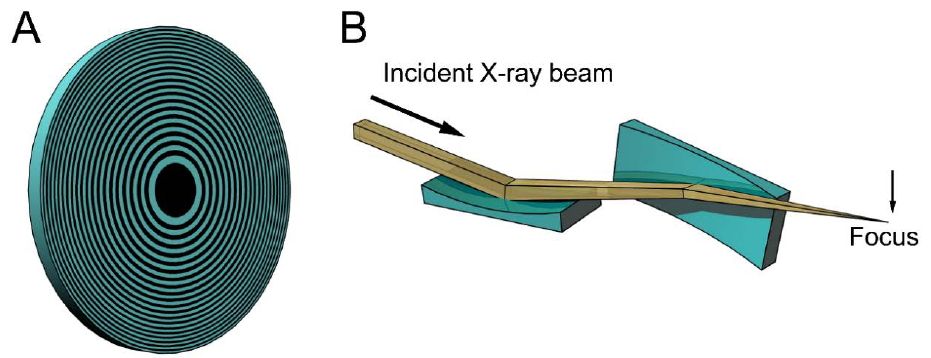
Figure 1. Schematic drawings of some focusing devices for X-ray beams. ( A ) Fresnel zone plate. This is a circular grating with alternating densities. The focal distance depends on the X-ray wavelengths and white X-rays do not focus; ( B ) Kirkpatric-Baez (KB) mirrors. These are most commonly used for focusing X-ray beams in synchrotron radiation facilities, but are rarely used as imaging optics. The focal distance does not depend on the X-ray wavelengths and can be changed by altering the bend of the mirrors. The drawings are exaggerated.